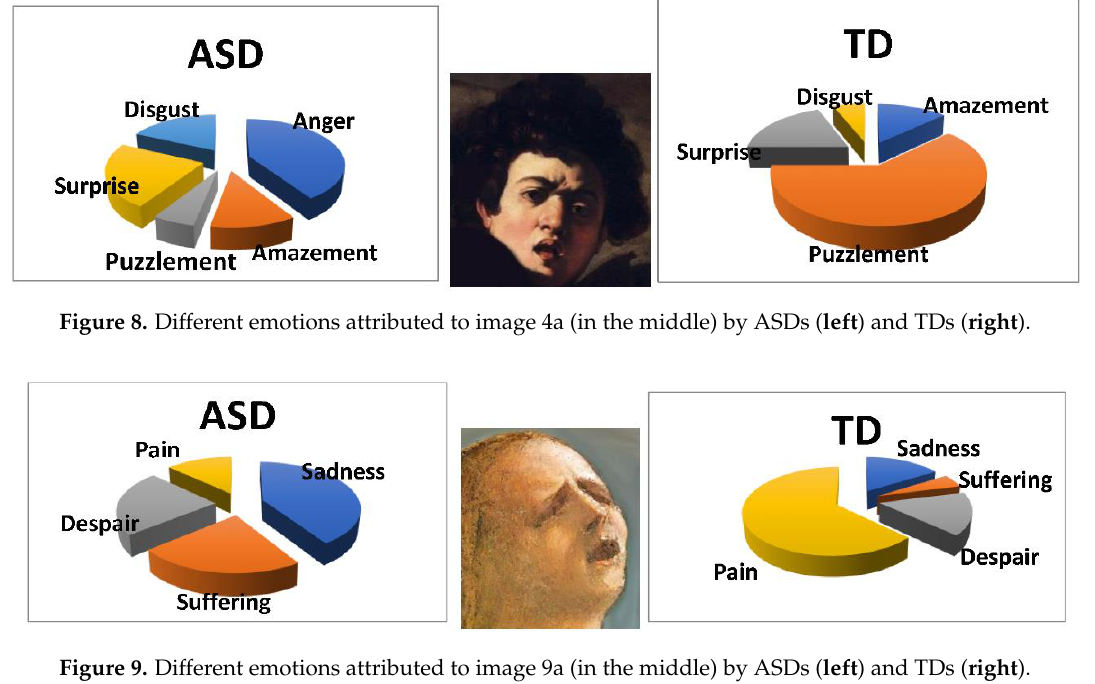
Table 1. Different emotions identified for face and body of the same static artwork.